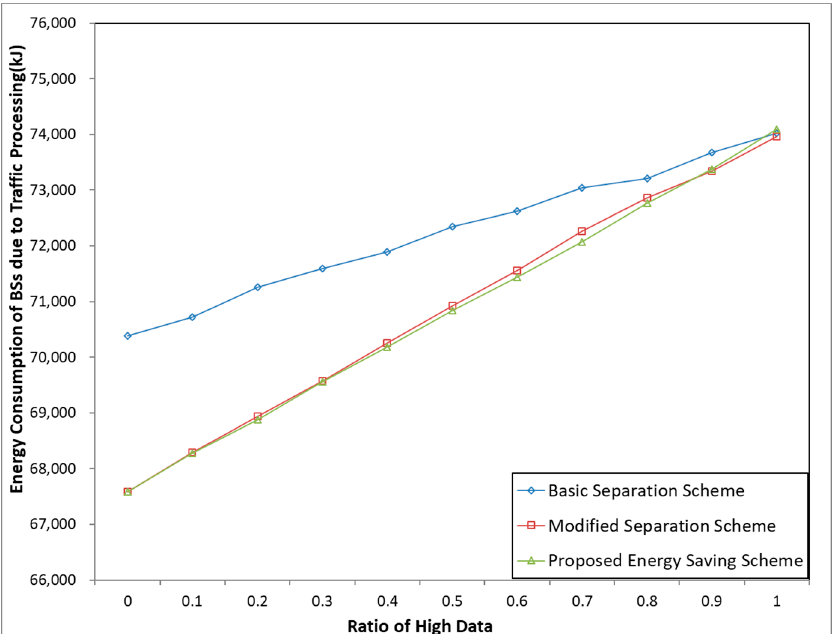
Figure 13. Energy consumption of BSs due to traffic processing.